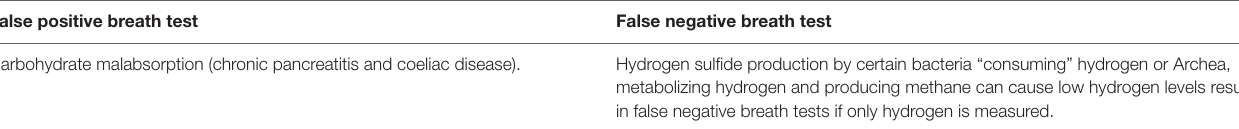
TABLE 1 | Causes for false positive and false negative indirect tests for small intestinal bacterial overgrowth (SIBO). False positive breath test False negative breath